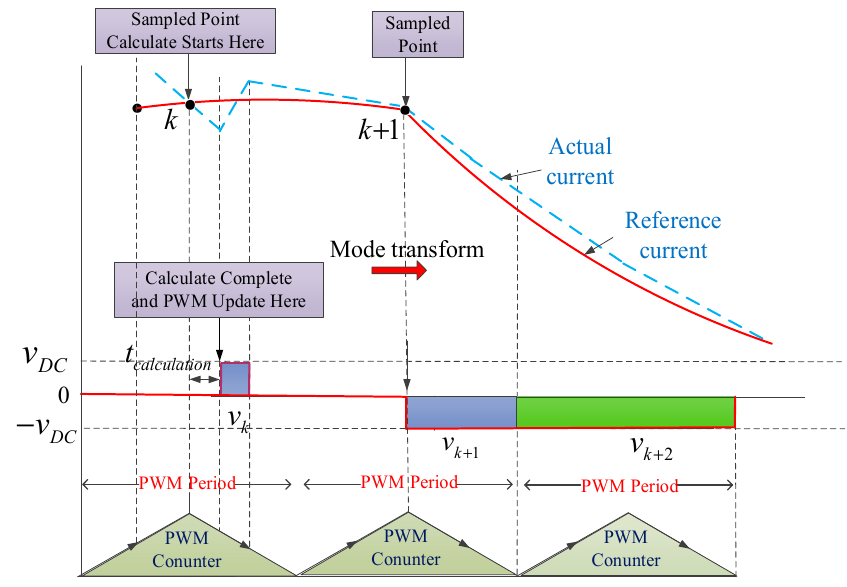
Figure 6. Duty ratio predicted at communication region.